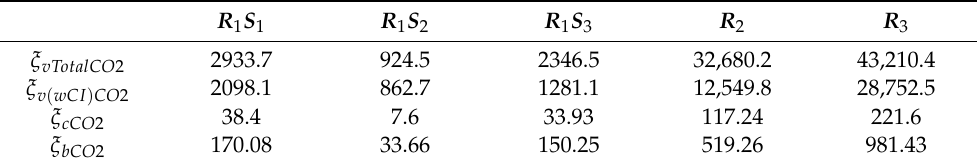
Table 17. Distribution of carbon emissions on selected routes for single transportation unit and vessel operation according to defined time periods (in kgCO 2 /trip-unit).